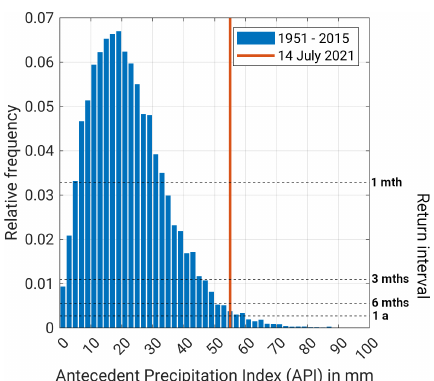
Figure 5. Frequency distribution of spatially averaged daily API values over LReg based on HYRAS (blue; 1951–2015). The red line marks the mean API on 14 July 2021 over LReg based on RADOLAN; the dashed black lines represent exemplary selected empirical return